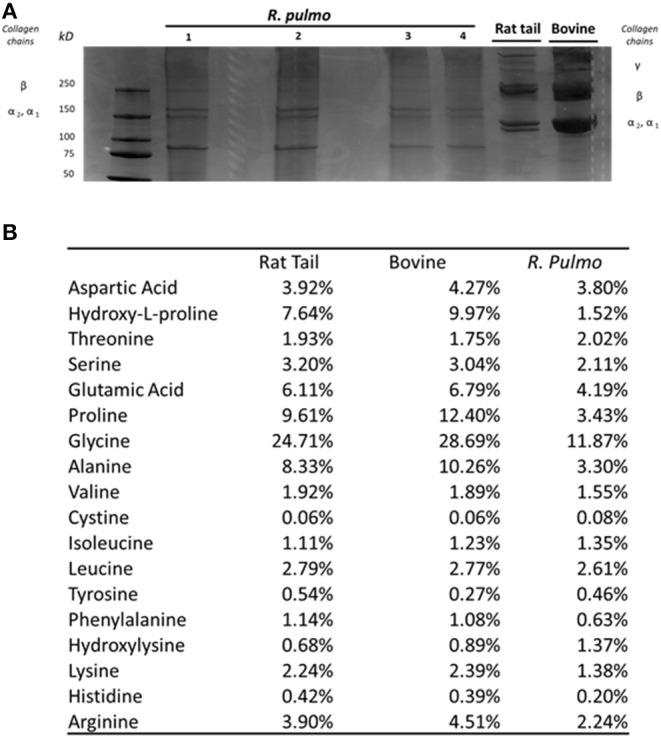
R. pulmo jellyfish electrophoretic banding and amino acid composition. (A) SDS-PAGE analysis of R. Pulmo, rat tail and bovine collagens. R. Pulmo collagen was loaded by volume: lane 1: 12 ul, lane 2: 10 ul; lane 3: 6 ul; and lane 4: 3 ul. Thirty microgram of rat tail and bovine collagen were used as controls. (B) Samples of acid solubilized R. Pulmo-rat tail-bovine collagen were compared for their amino acid composition.